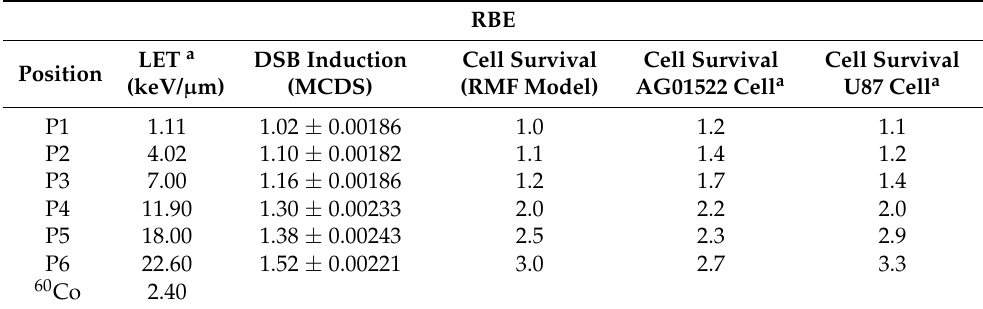
Table 4. RBE for cell survival at 10% Using the RMF model with parameter j = 9 and an irradiated dose = 1 Gy under normal oxygen concentration (21% O 2 ).